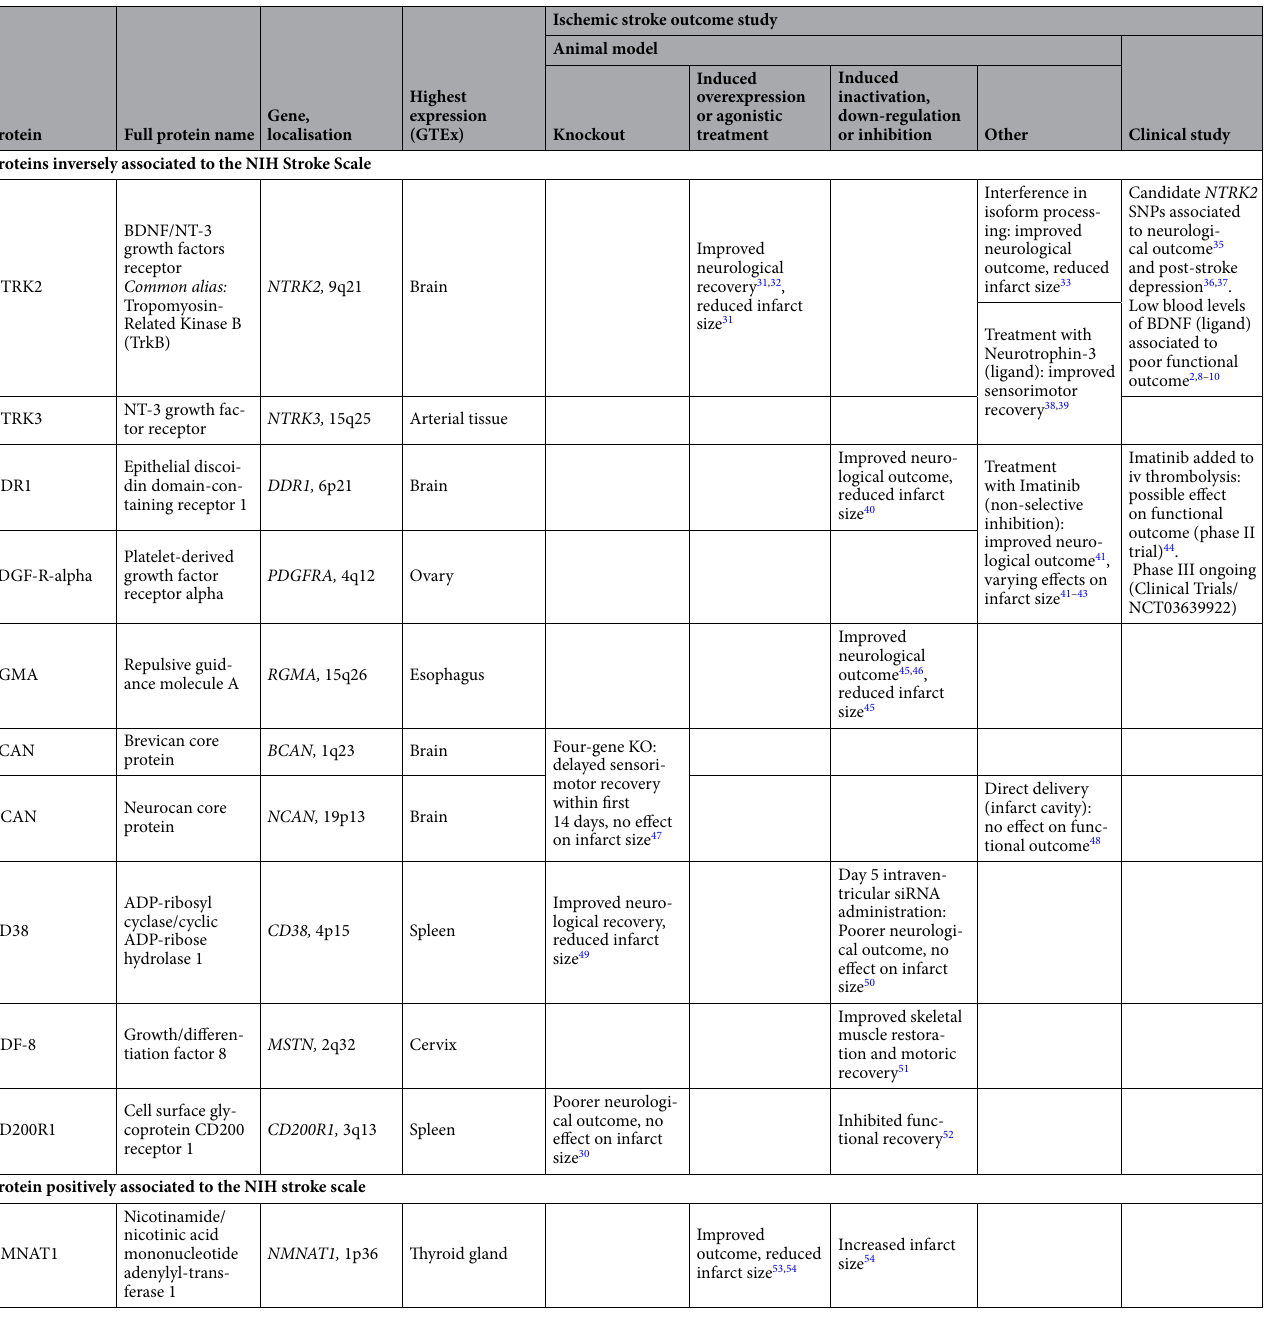
Table 2. Candidate acute and 3-month protein markers statistically significantly associated to neurological outcome in the present study, for which experimental ischemic stroke models provide evidence or suggestion of a causal influence on functional outcome. SNP Single Nucleotide Polymorphism, KO Knockout, iv intravenous, siRNA Small interfering